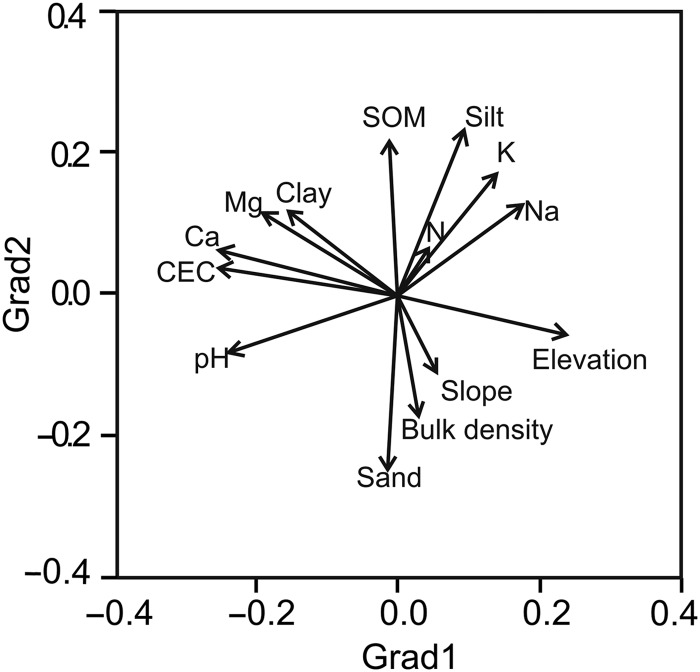
Ordination results of soil and topographic variables using principal component analysis. Principal component 1 (Grad1) and principal component 2 (Grad2) explained 29 and 24% of the variance, respectively (53% total explained variance). Full names of environmental variables are given in the Materials and methods section.